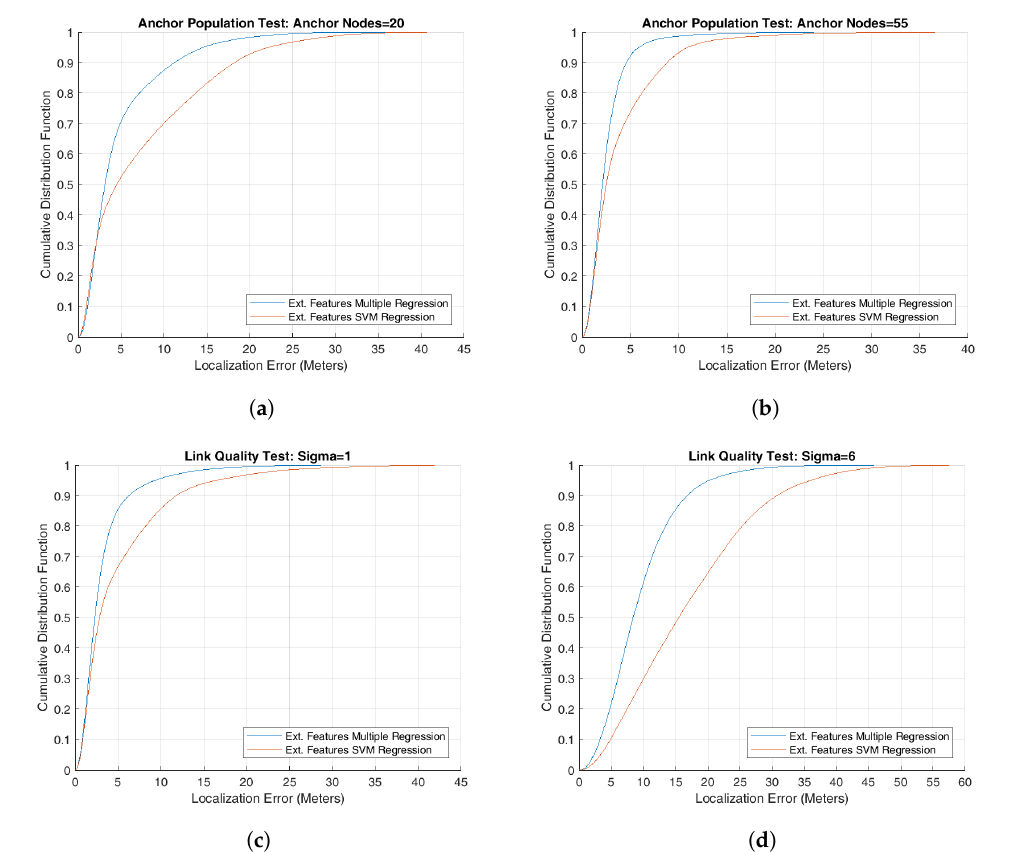
Figure 2. Empirical cumulative distribution function of localization error plotted for the extended feature set regression models for anchor population and link quality